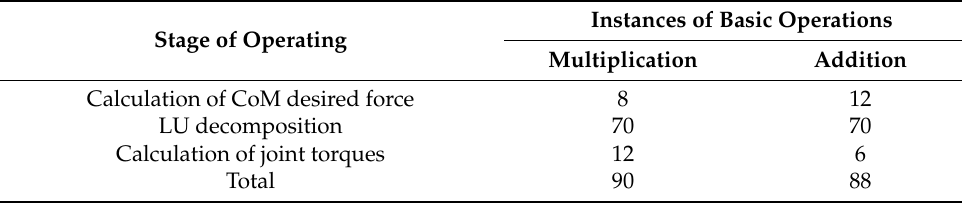
Table 2. Instances of Basic Operations During Main Process of